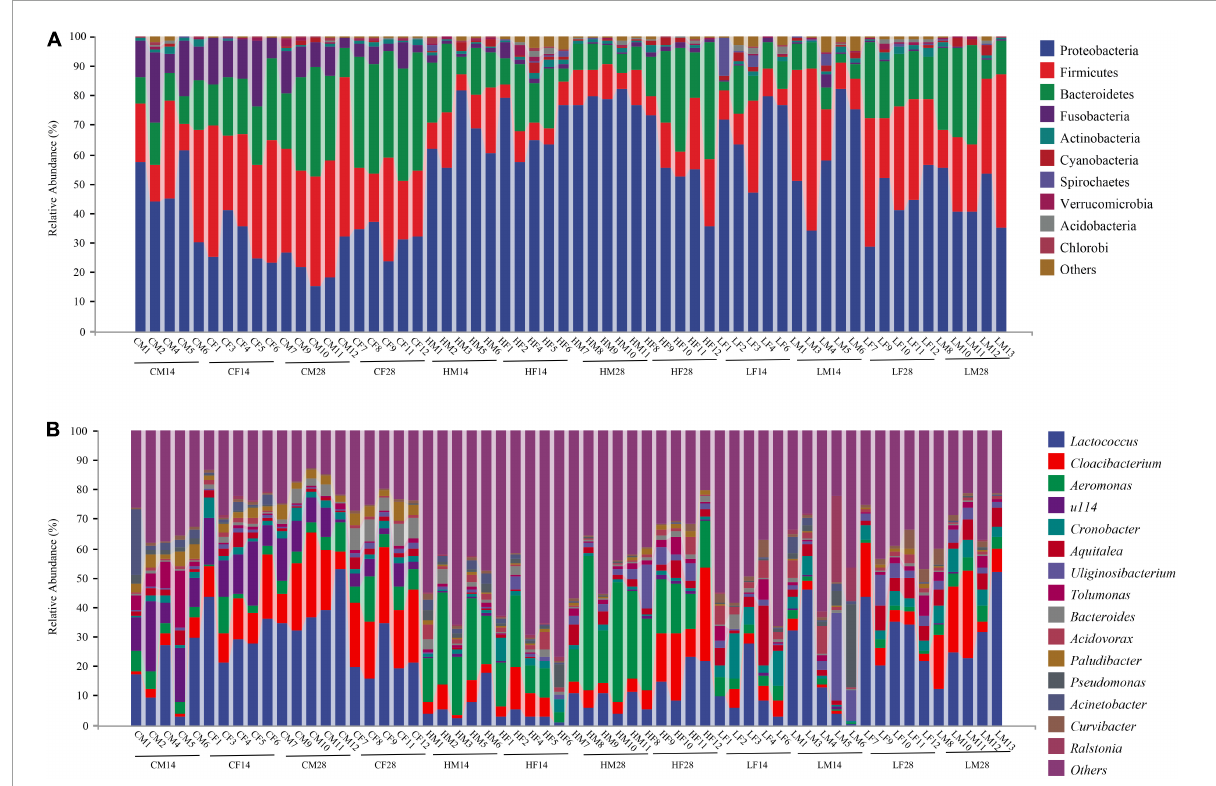
FIGURE4 Abundance at the phylum (A) and genus (B) level of intestine microbiota in Pomacea canaliculata treated in different temperatures (mean relative abundance >